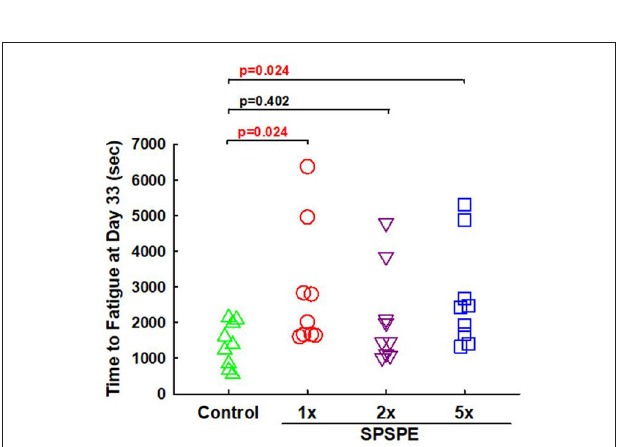
FIGURE 3 | Effect of SPSPE treatment on the results of swimming exhaustive test in rats. After treatment for 32 days, the rats were fasting for 12h. The next day, the rats were administrated with different doses of SPSPE and stayed in their cages for 60min, and then the rats performed a swimming exhaustive